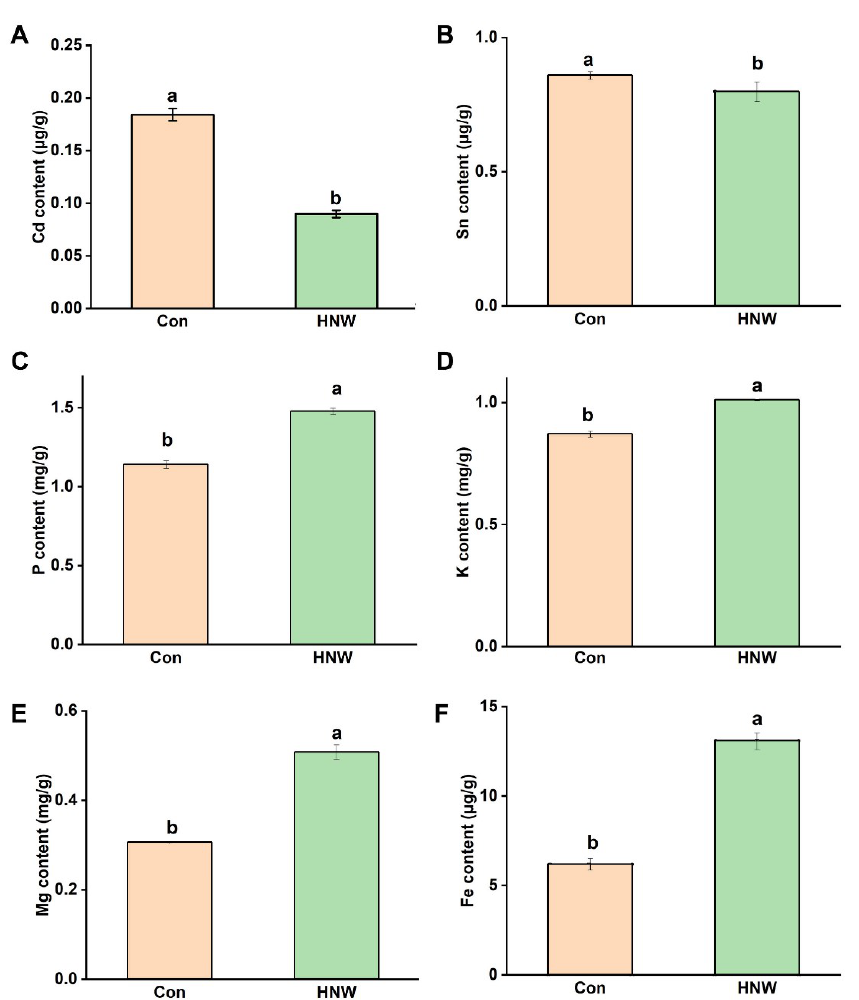
Figure 8. HNW affects the absorption of heavy metal and some nutrient element in white rice. The heavy metal content was analyzed, including Cd ( A ) and Sn ( B ). Meanwhile some nutrient elements, including phosphorus ( C ), potassium ( D ), magnesium ( E ), and iron ( F ), in white rice were further determined. Data are mean ± SD (n = 3). Bars with different letters were significantly different in comparison with Con at p < 0.05.